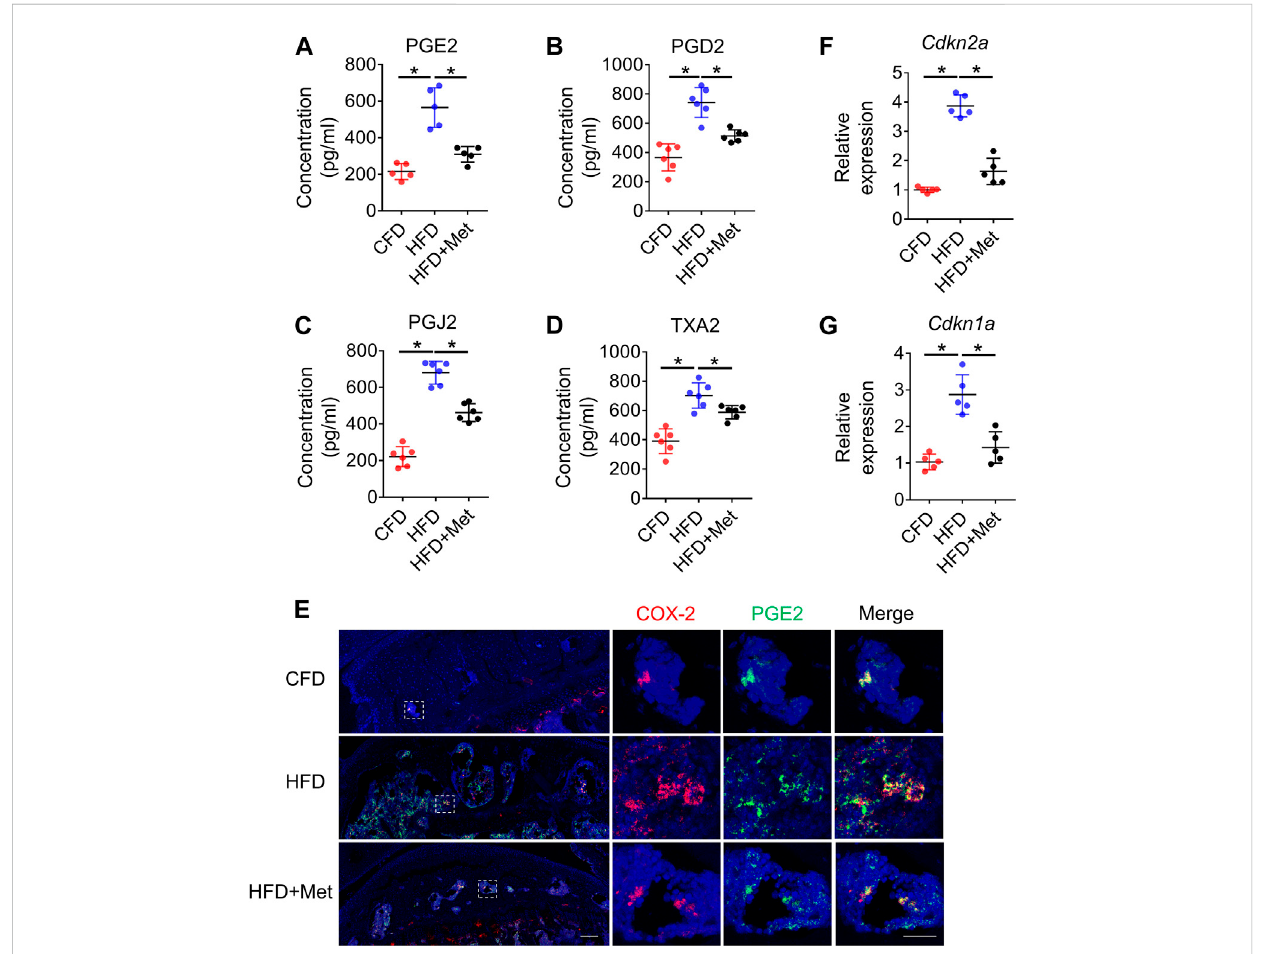
FIGURE 2 Metformin reduces PGs level and cellular senescence in subchondral bone in mice treated with HFD. Three-month-old C57BL/6 mice were fed a standard chow-food diet (CFD), HFD, or HFD with metformin (HFD + Met) for 3 months. n = 6 mice per group. (A – D) Relative protein concentrations of PGE2 level (A) , PGD2 level (B) , PGJ2 level (C) , and TXA2 level (D) in subchondral bone of mice treated with CFD, HFD, or HFD + Met. (E) Immuno fl uorescence staining of knee joint tissue sections with antibody against COX-2 (red) and PGE2 (green). (F, G) RNA was isolated from harvested tibialplateau andmRNAlevels of Cdkn2a and Cdkn1a weremeasuredbyqRT-PCRanalysis. Alldataareshown asmeans±standarddeviations. * p < 0.05. Statistical signi fi cance was determined by one-way